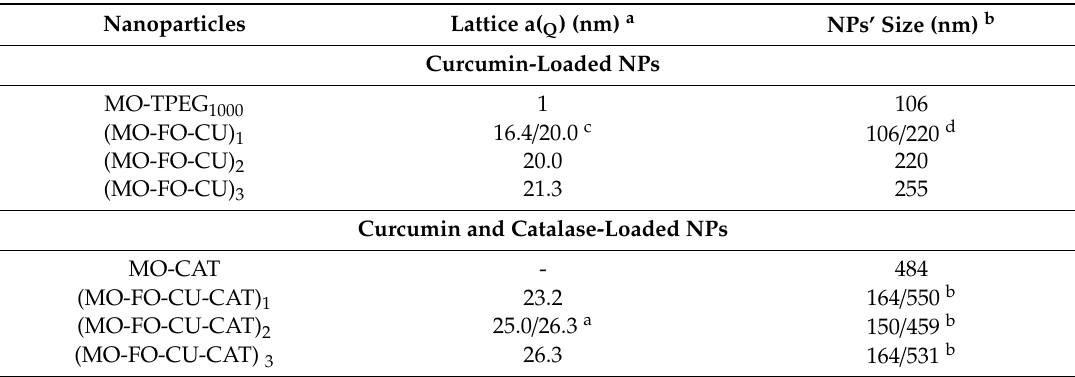
Table 2. Unit cell lattice parameters and size distributions of catalase-free and catalase-loaded MO / FO / CU cubosome nanoparticles (NPs) stabilized by TPEG 1000 . The cubic space group type is indicated in Figure 5 for every